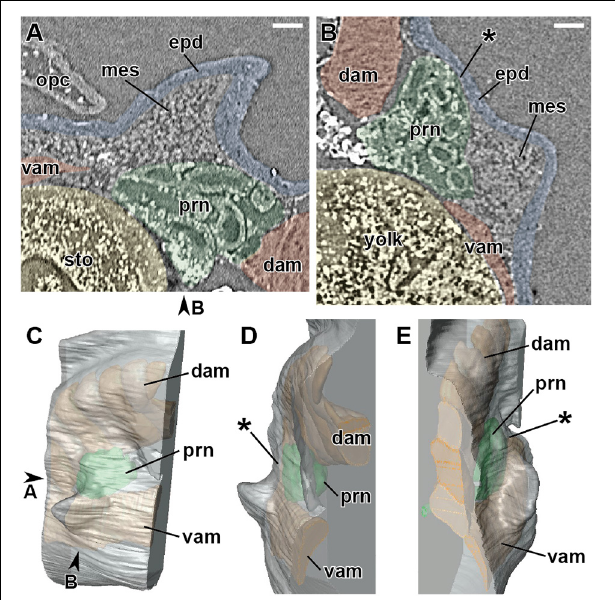
FIGURE 1 | Developing right pectoral fin of Neoceratodus forsteri at stage 46 (total length = 13.5 mm). (A) Coronal section. (B) Transverse section. (C) Lateral view. (D) Cranial view. (E) Caudal view. dam, dorsal axial muscle; epd, epidermis; mes, mesenchyme; opc, operculum; prn, pronephros; sto, stomach; vam, ventral axial muscle. Arrowheads indicate the respective sectioned levels. The asterisk marks the junction between the axial body wall and fin bud, where no mesenchymal tissue is observable at this developmental stage. Scale bar = 100 µ